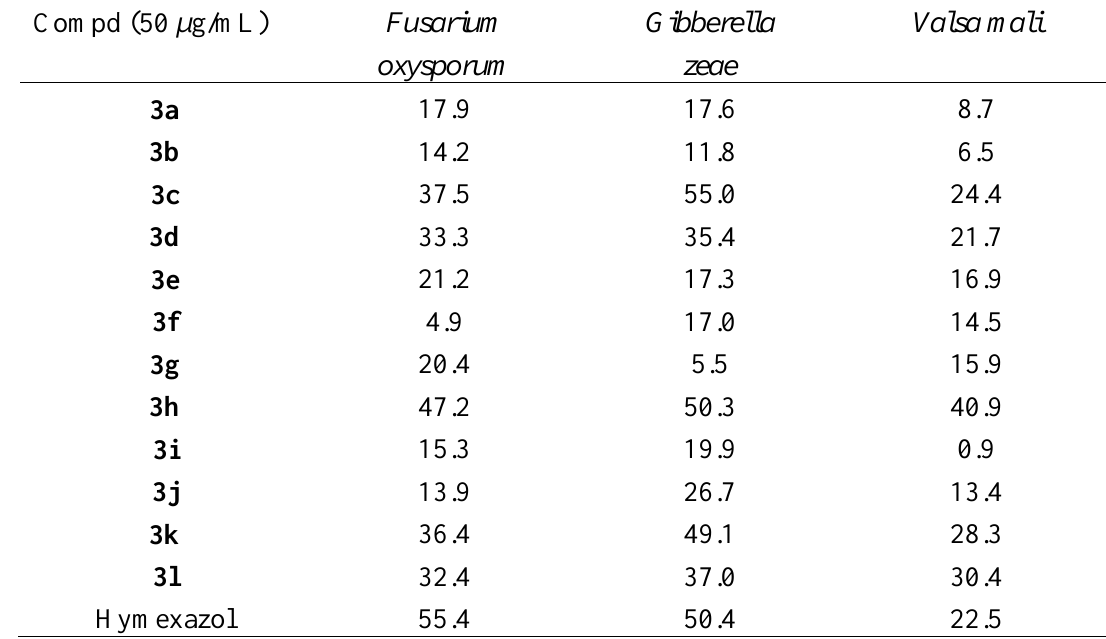
Table 4. Inhibition effect of 3-alkylquinazolin-4-one derivatives on phytopathogenic